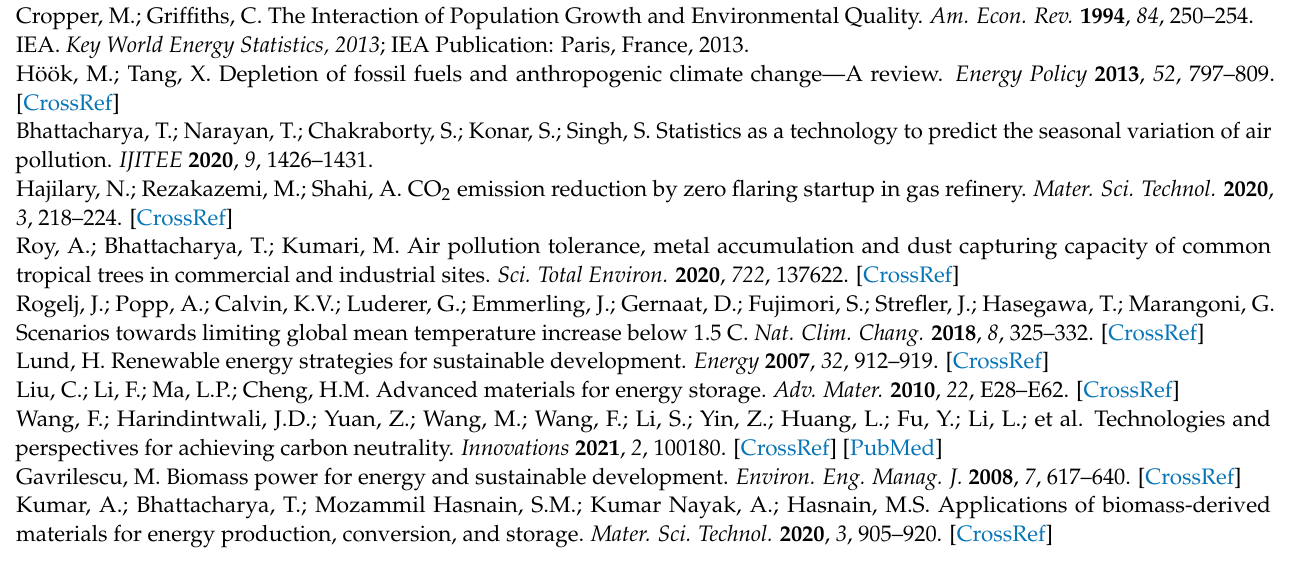
(TAc); Figure S2: Cross-linked binder (C-PAA/TAc) formed by condensation between PAA and TAc; Figure S3: Reaction of antioxidant and DPPH free radical; Figure S4: Optimization of DPPH assay: Color response as a function of the DPPH concentration; Figure S5: (a) Optical images of the tapes peeled from the Si PVDF, Si TAc, Si C-PAA/TAc, and Si PAA electrodes; (b) 180 ◦ peel-off test results of Si PVDF, Si TAc, Si C-PAA/TAc, and Si PAA electrodes EIS data of Si PAA, Si TAc and Si C-PAA/TAc; (c) the average peeling forces; Figure S6: Schematic assembly illustration of Si (cid:107) Li half cell configuration; Figure S7: Cycling performance of Si C-PAA/TAc low (~0.35 mg cm − 2 ) and high (~1.1 mg cm − 2 ) loading at 0.5 C-rate; Table S1: Electrochemical performances of Si PAA, Si TAc and Si C-PAA/Tac; Table S2: EIS data of Si PAA, Si TAc and Si C-PAA/TAc after 100th